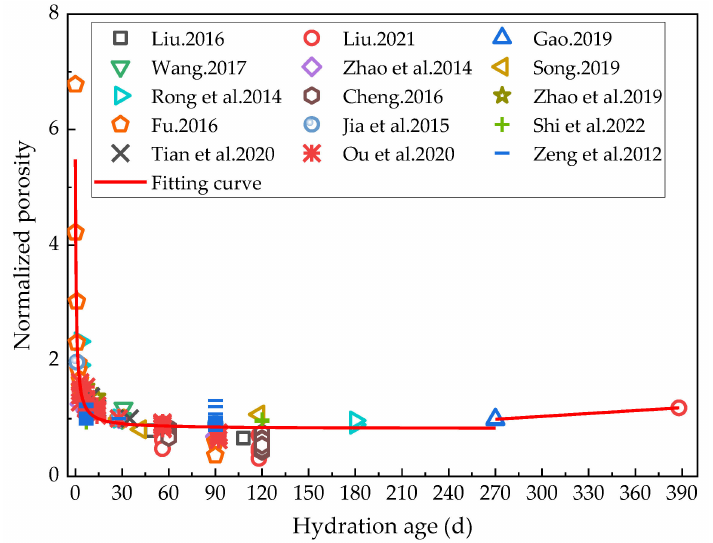
Figure 7. Relationship between porosity and hydration age